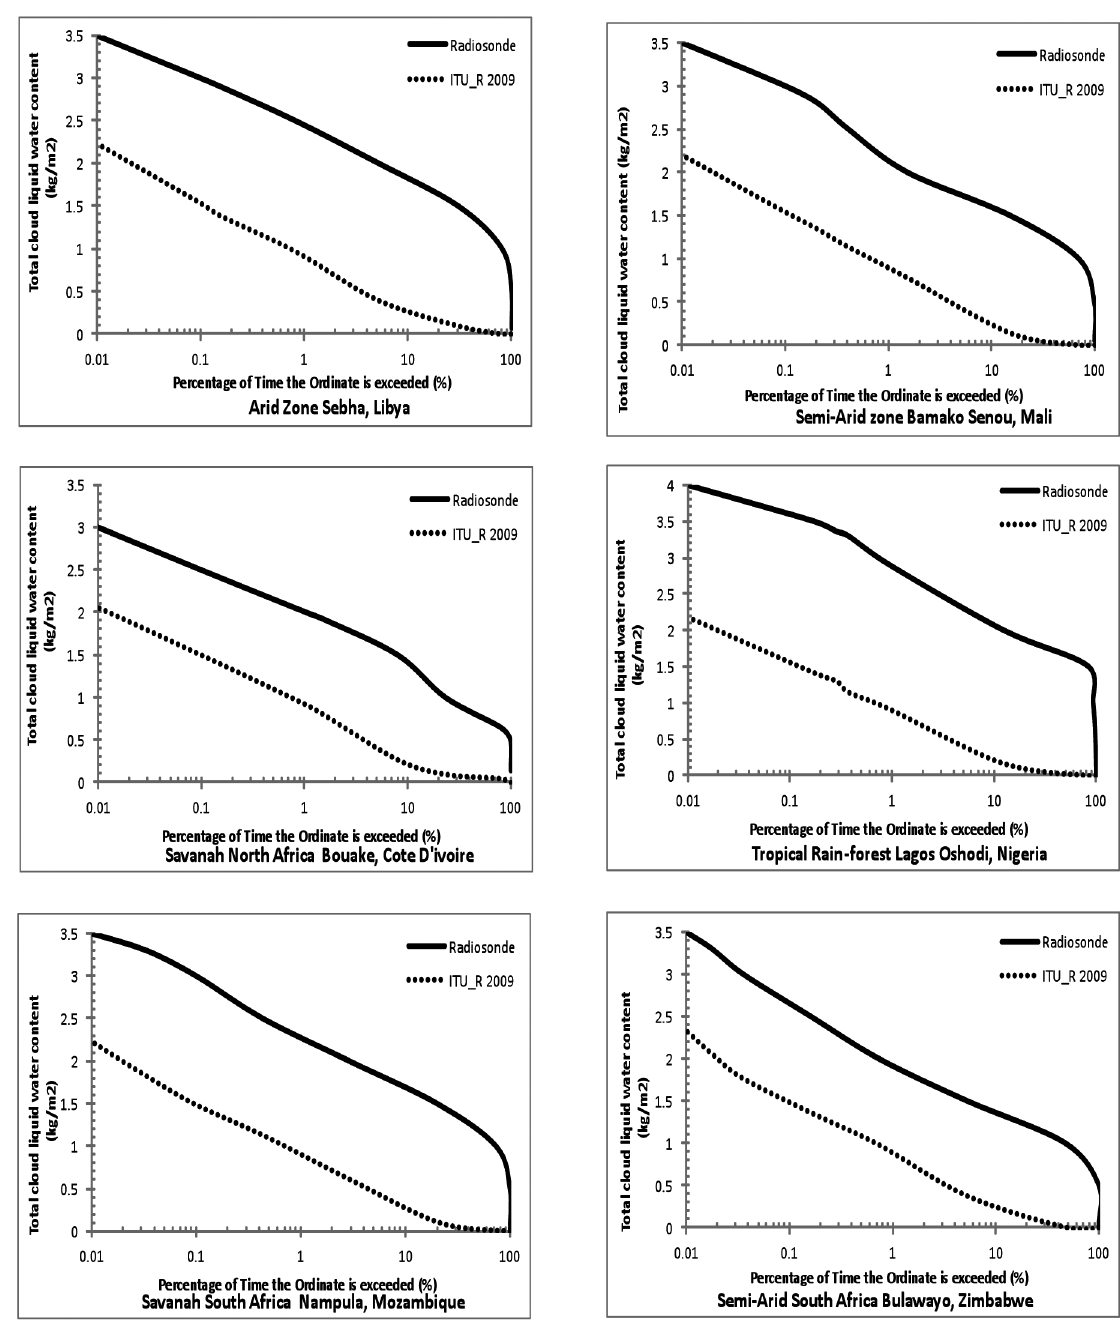
Figure 9. Cumulative distribution of total cloud liquid water content (kg/m 2 ) obtained from radiosonde measurements; also shown is the data obtained from the ITU-R model for the six major climatic zones of